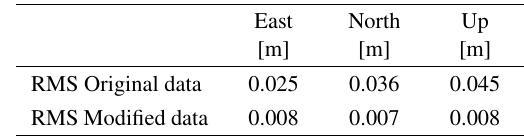
Table 1. Deviations of test points to the terrestrial reference